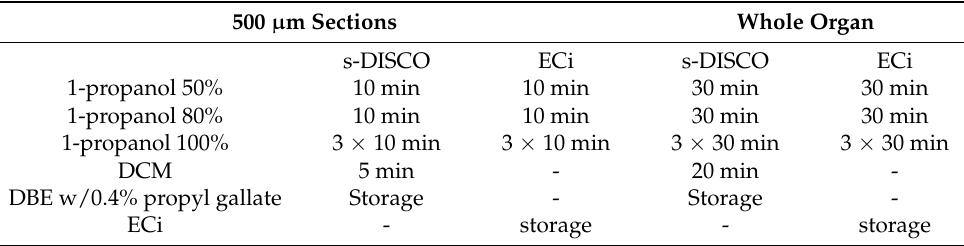
Table 1. Solvent-based clearing protocols. The RI matching solvents used were ethyl cinnamate